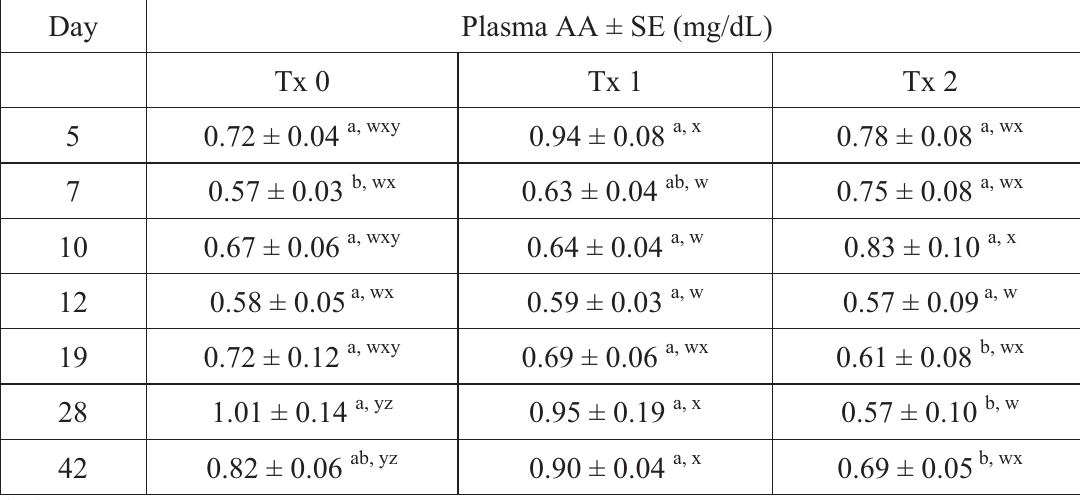
Table 1. Mean plasma AA concentrations relative to tx group and day after arrival. Lowest